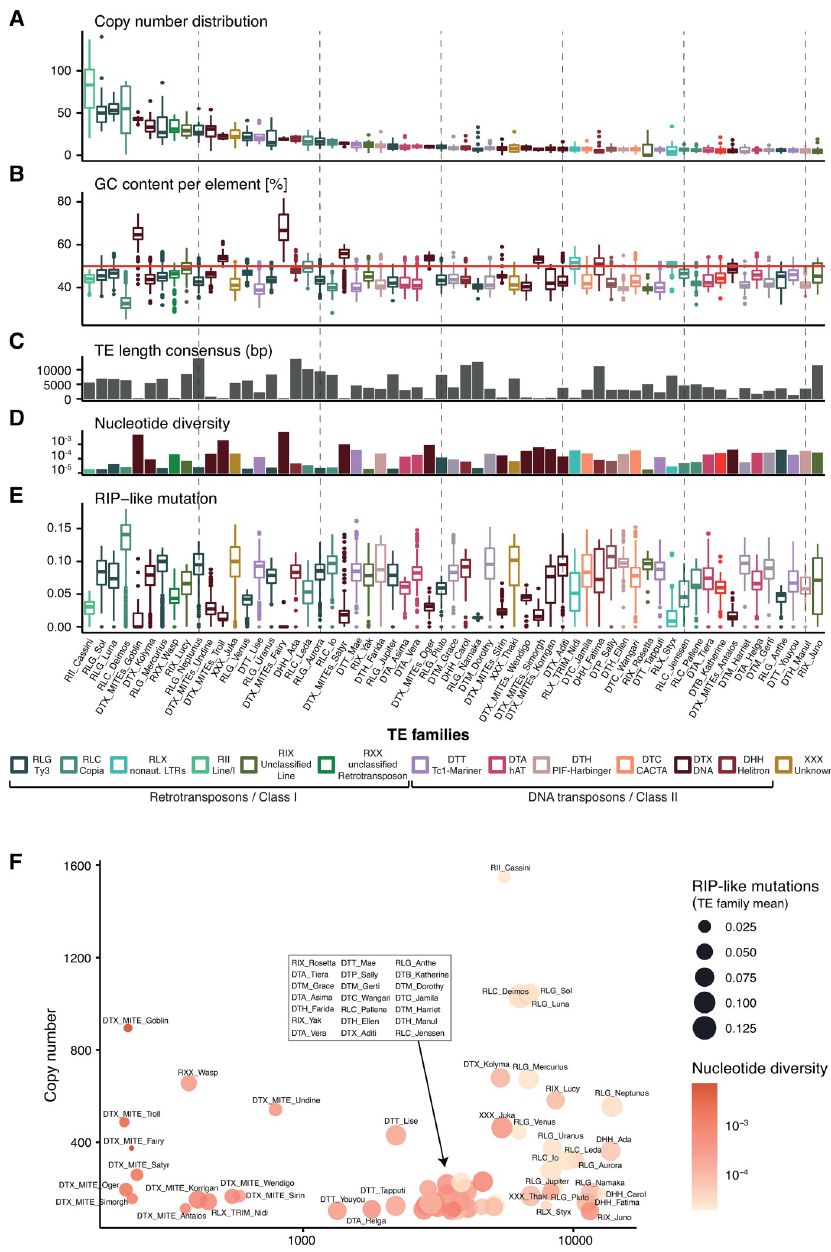
Fig 4. Characteristics of high-copy TE families: TE families are ordered from the highest copy numbers to lowest copy numbers (right) in all 19 analyzed genomes combined. (A) Distribution total copy number per TE family and isolate. (B) GC content distribution per TE family. The red line represents a GC content of 50%. (C) Length of the consensus sequence corresponding to the full-length consensus sequence excluding nested TEs or partial deletions. (D) Nucleotide diversity of the TE family (transformed as log10(nucleotide diversity � 100,000)). (E) Number of RIP-like mutation (CpA < - > TpA/TpG < - > TpA) per TE copy, corrected for the length of the TE. (F) Correlation between copy numbers and consensus sequence lengths for TE families. Circle size corresponds to the mean number of RIP-like mutations and the color indicates the nucleotide diversity.